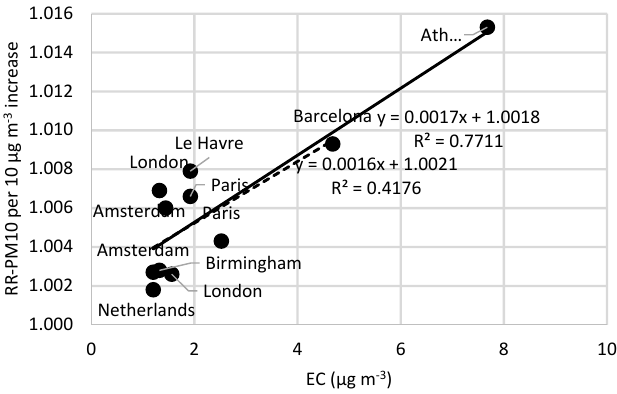
Figure 4. The relative risks of all-cause mortality associated with short-term exposure to PM 10 as a function of the levels of elemental carbon (EC). The slope of the solid line is significant (95% CI). The dashed line represents the relationship where Athens is excluded. The EC concentrations are based on BS values transformed by using the calculated mean of 12% EC content in BS.